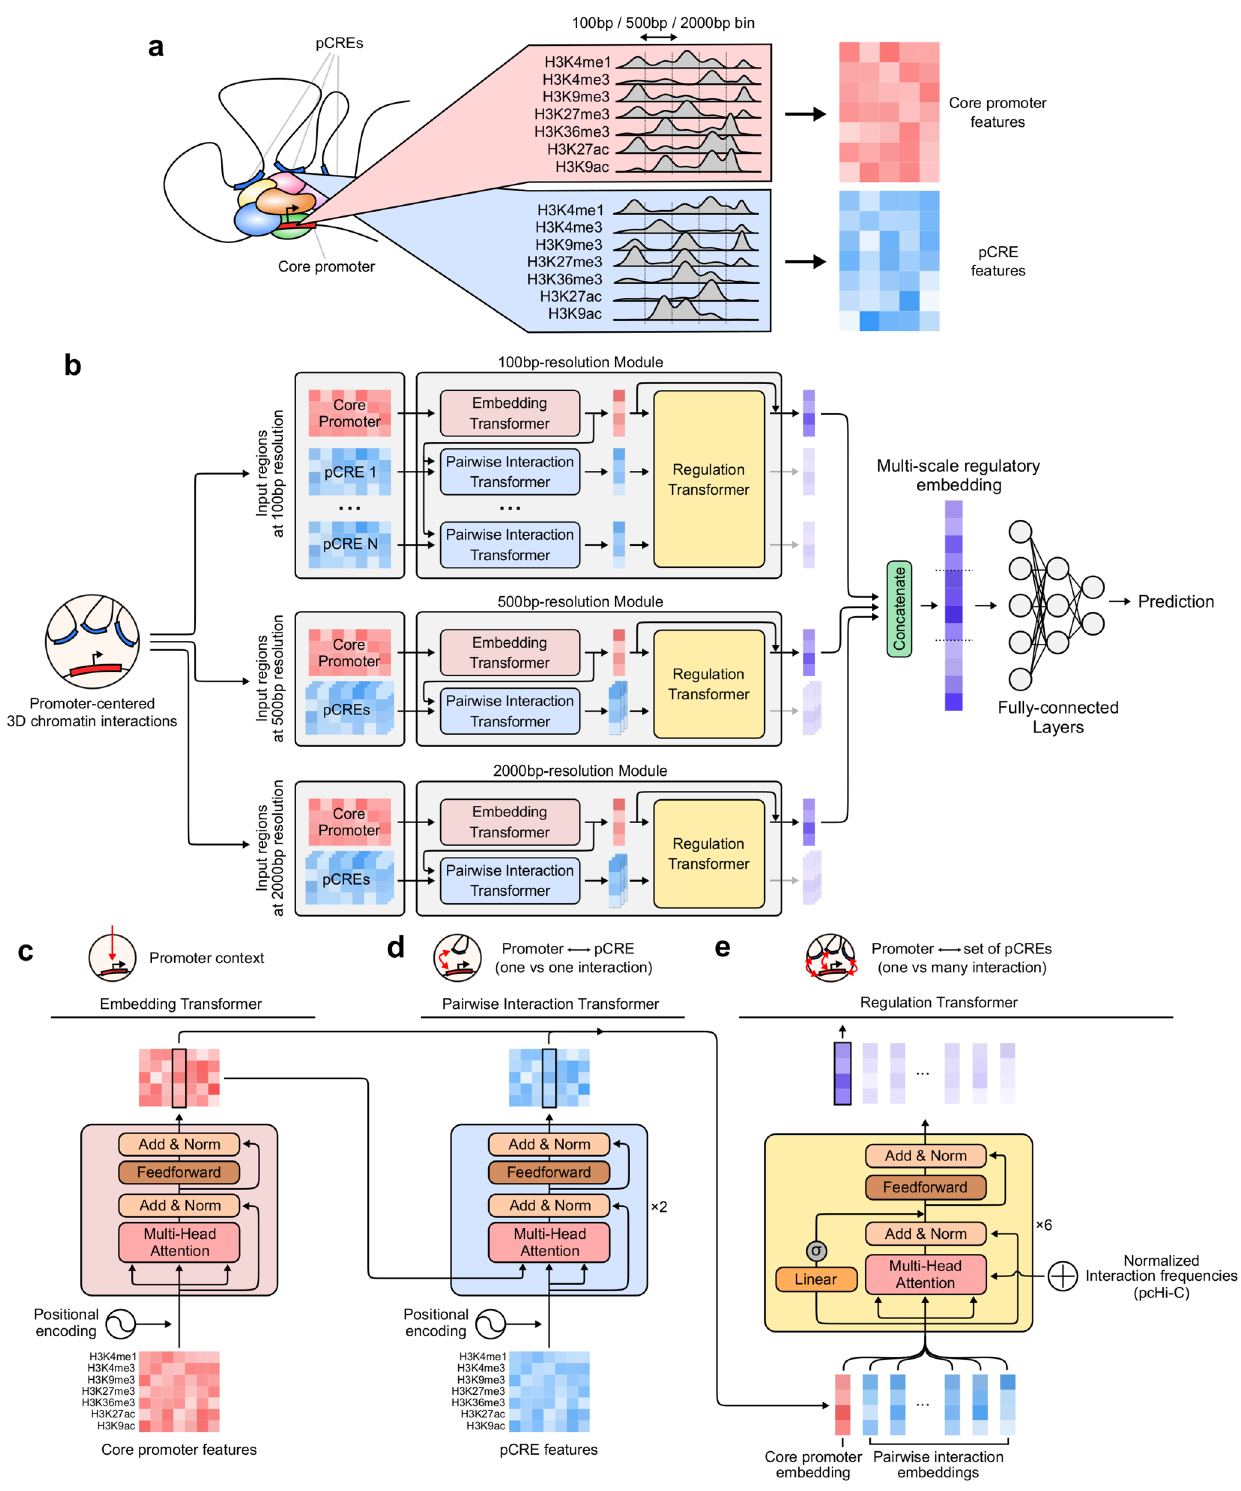
Fig. 1 | Chromoformer model architecture. a Input features. To predict the expression of a gene using levels of histone modi fi cations (HMs), we extracted binned average signals of HMs from both the core promoter and putative cis - regulatory regions (pCREs). b Chromoformer architecture. Three independent modules were used to produce multi-scale representation of gene expression regulation. Each of the modules is fed with input HM features at different resolutions to produce an embedding vector re fl ecting the regulatory state of the core promoter. c Embedding transformer architecture. Position-encoded HM signals of core promoter features are transformed into core promoter